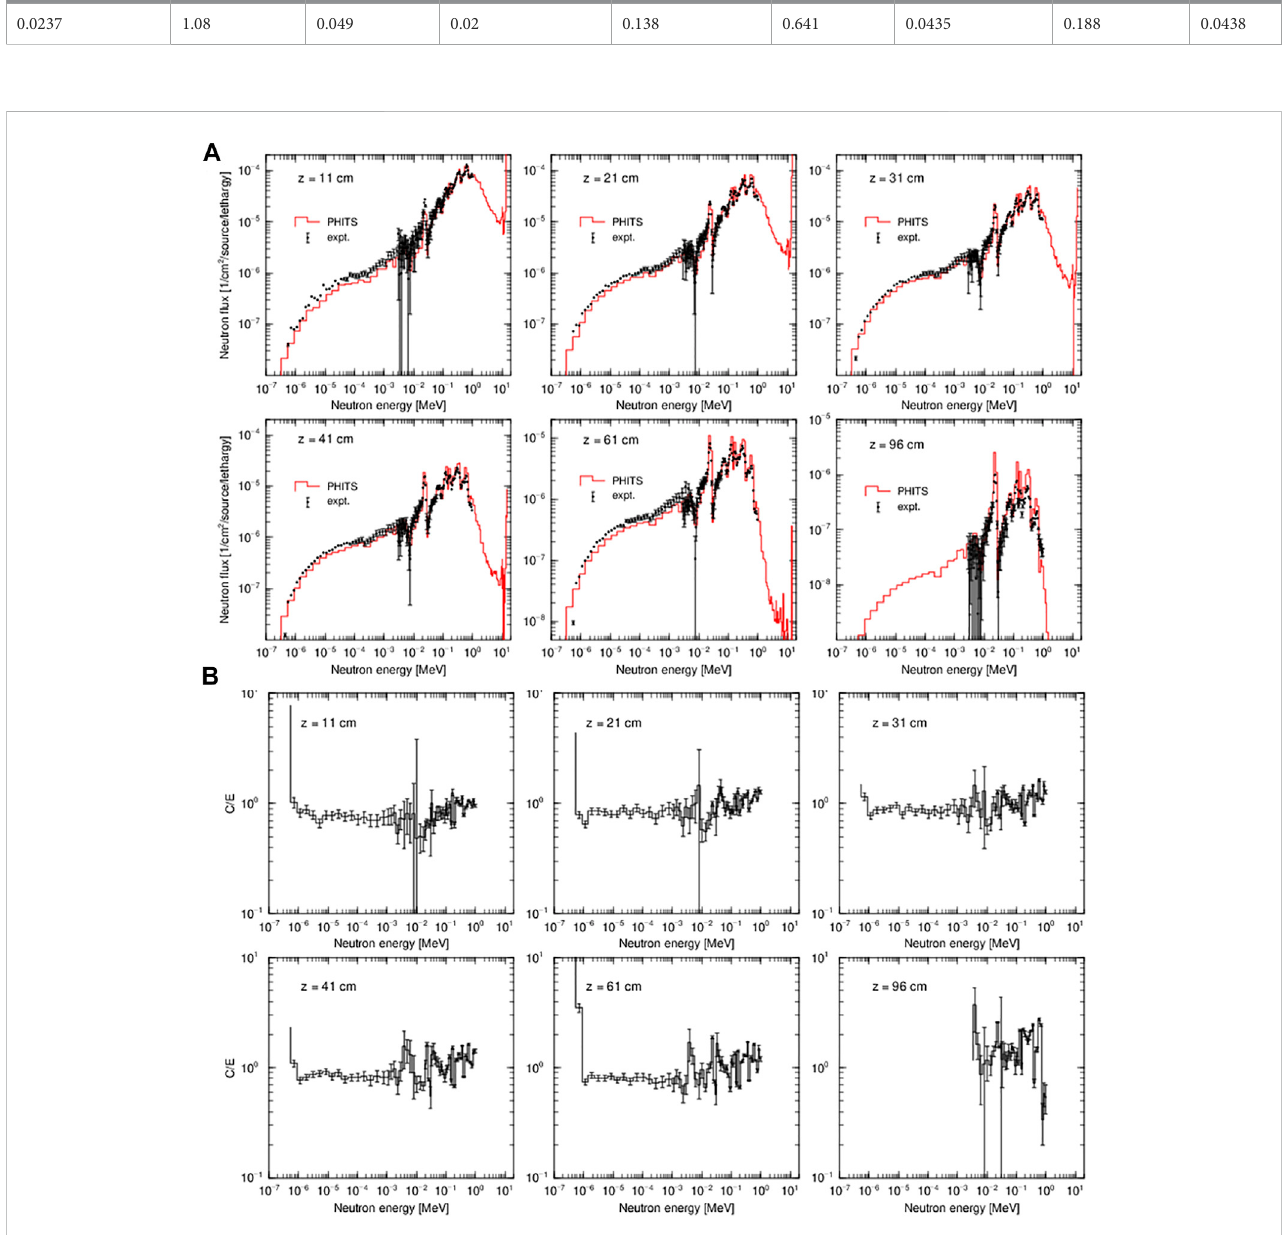
FIGURE 6 (A) Neutron energy spectra at each depth in the iron shield for a 350-keV D-T neutron source. The experimental data only includes uncertainty due to counting statistics. (B) The ratio of calculation results and experimental data to the neutron energy. Note that there are places where the energy bins in the experimental neutron fl ux plots are different from those in the calculated